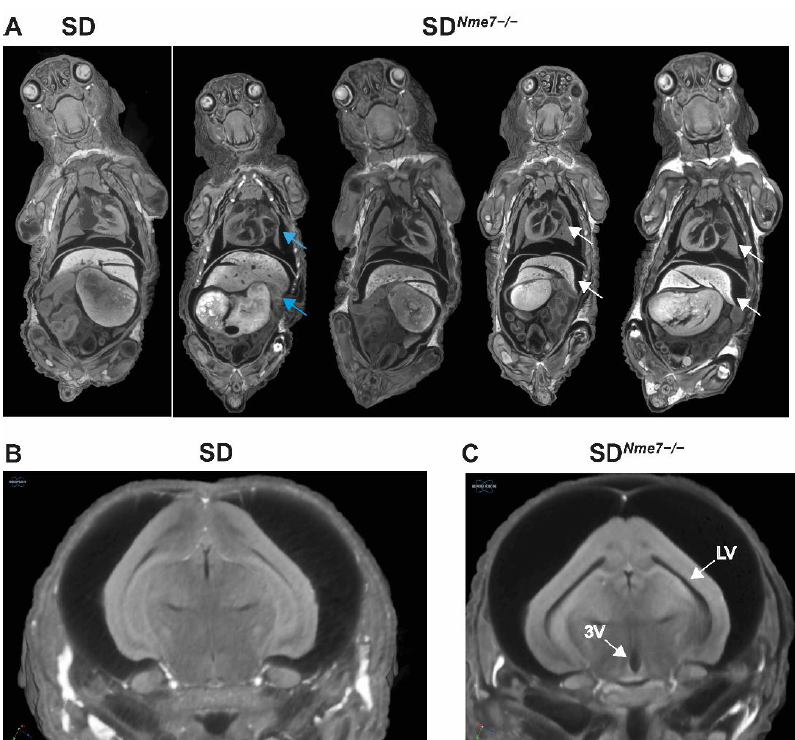
Figure 3. Micro-CT showing ( A ) situs inversus totalis with dextrocardia (white arrows) and 90° rotation of inner organs (blue arrows) in SD Nme7 − / − rats in comparison with SD control rat (all P1). Detailed view of enlarged lateral ventricles (LV) and 3rd ventricle (3V) in brains of SD Nme7 − / − rats ( C ) compared to SD rats ( B ).